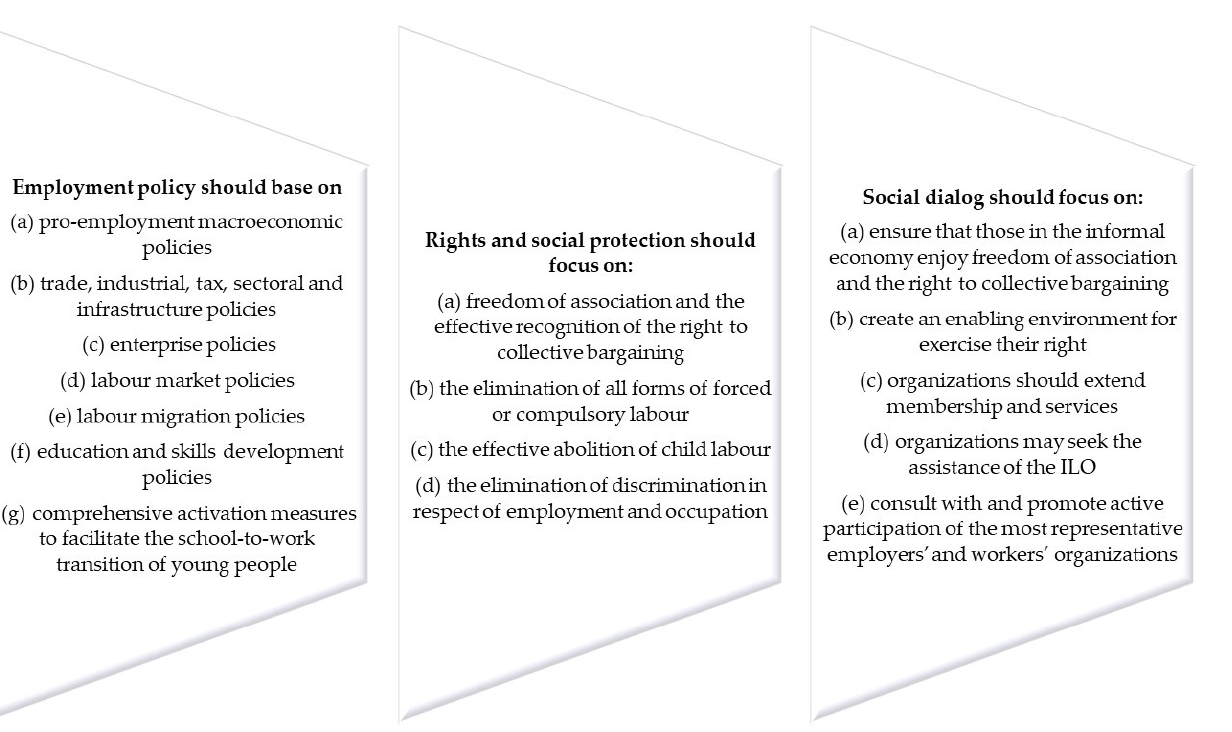
Figure 4. Framework to improve decent work of the Recommendation 204. Source: own illustration based on the Recommendation 204.